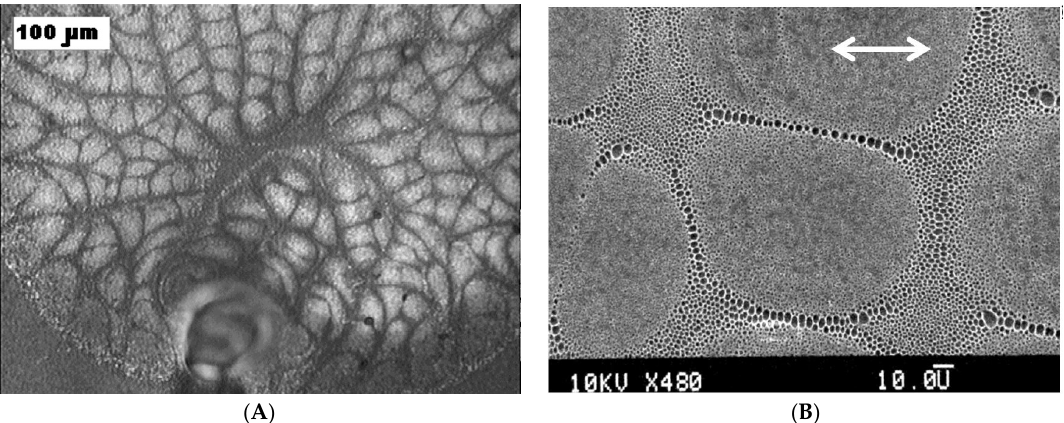
Figure 3. Large ‐ scale pattern typical for breath ‐ figure self ‐ assembly (Polystyrene (5 wt %) was dissolved in a mixture of dichloromethane CH 2 Cl 2 (90 wt %) and chloroform CHCl 3 (5 wt %) and deposited by dip ‐ coating on the polyethylene substrate). ( A ) The scale bar is 100 μ m; ( B ) the scale bar is 50 μ m [97] (Copyright 2007 Wiley).